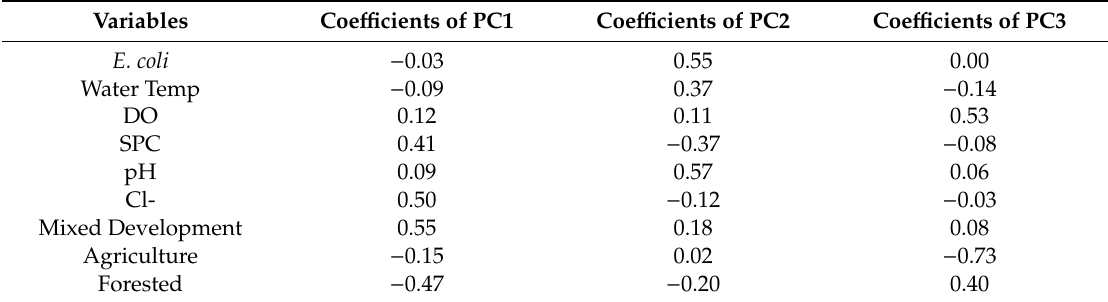
Table A7. Coe ffi cients of annual principal components comprising 9 variables ( E. coli concentration, water temperature, DO, SPC, pH, chloride, percentage of mixed developed land use, percentage of agricultural land use and percentage of forested land use) used to define 9 principal components,